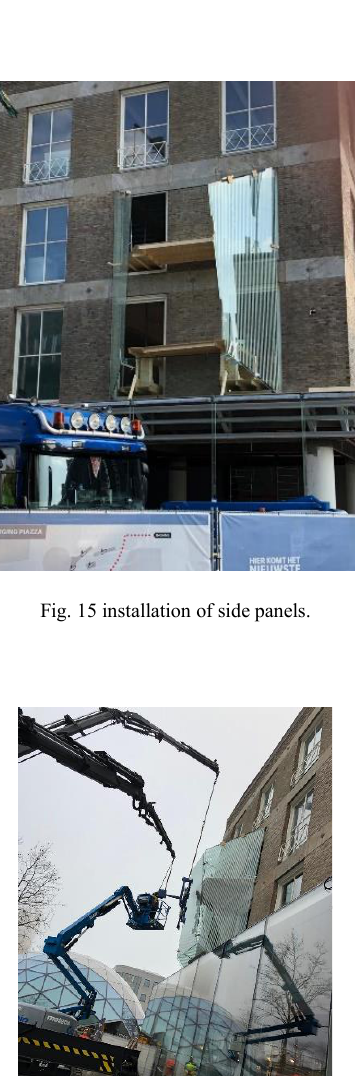
Fig. 13 frame to check dimensions existing façade. Fig. 14 photos made during production.